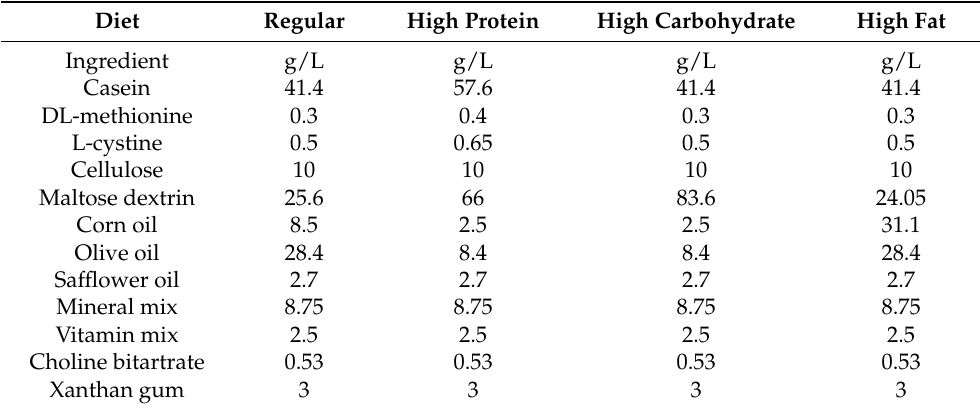
Table 1. Nutrient composition of high protein, high carbohydrate, and high fat liquid diet.